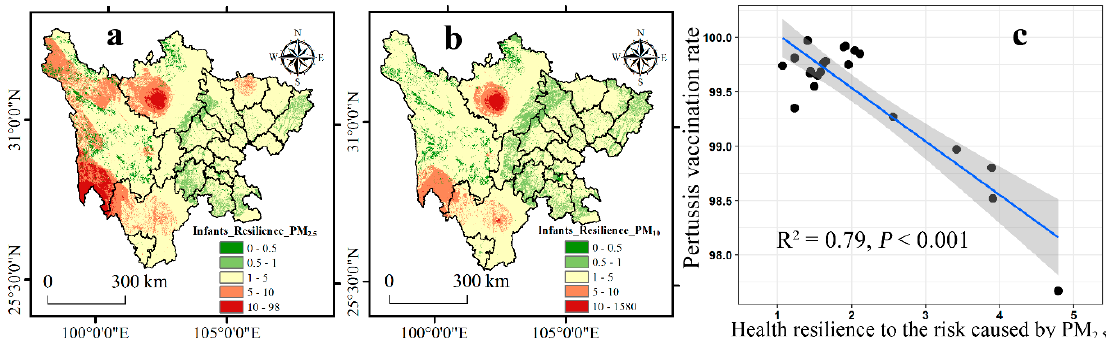
Figure 5. The health resilience of infants to the risk caused by ( a ) PM 2.5 (Infants_Resilience_PM 2.5 ) and ( b ) PM 10 (Infants_Resilience_PM 10 ); ( c ) the correlation between the pertussis vaccination rate and average health resilience of infants to the risk caused by PM 2.5 in 21 cities in Sichuan.